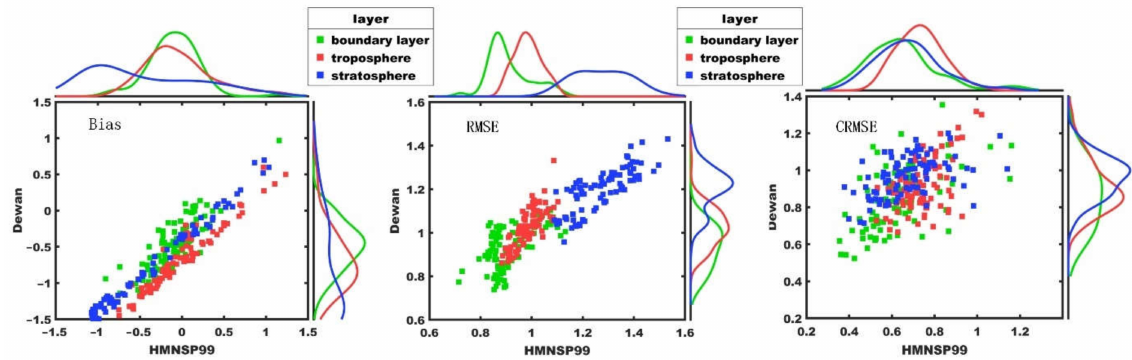
Figure 3. Statistical analysis of log C 2 n calculated by HMNSP99 and Dewan model for eighty-nine flights of individual meteorological balloons.